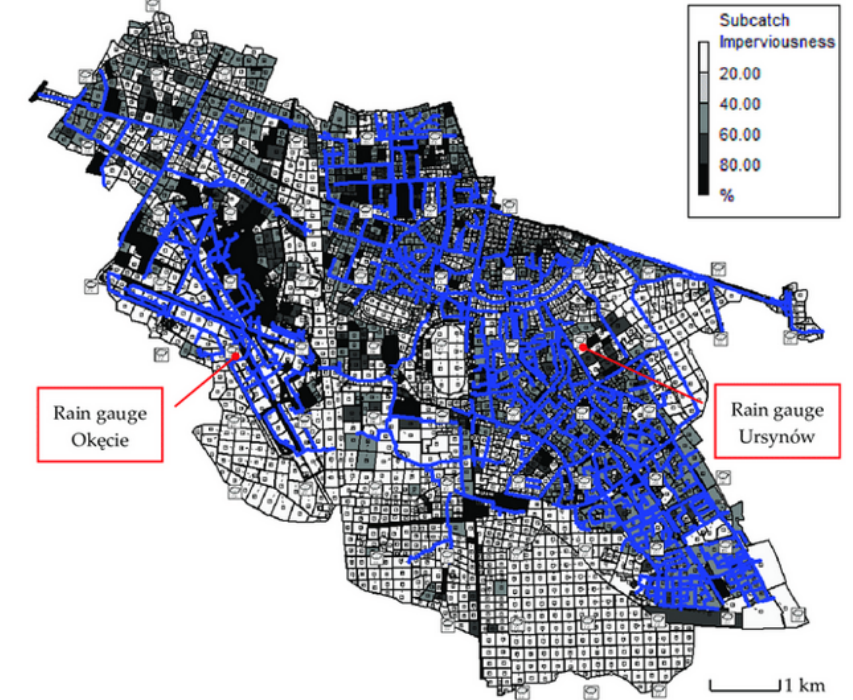
Figure 3. Słu˙zewiecki Stream Subcachments (note: stormwater sewer system and channels are Figure 3. S ł u ż ewiecki Stream Subcachments (note: stormwater sewer system and channels are marked in blue). marked in